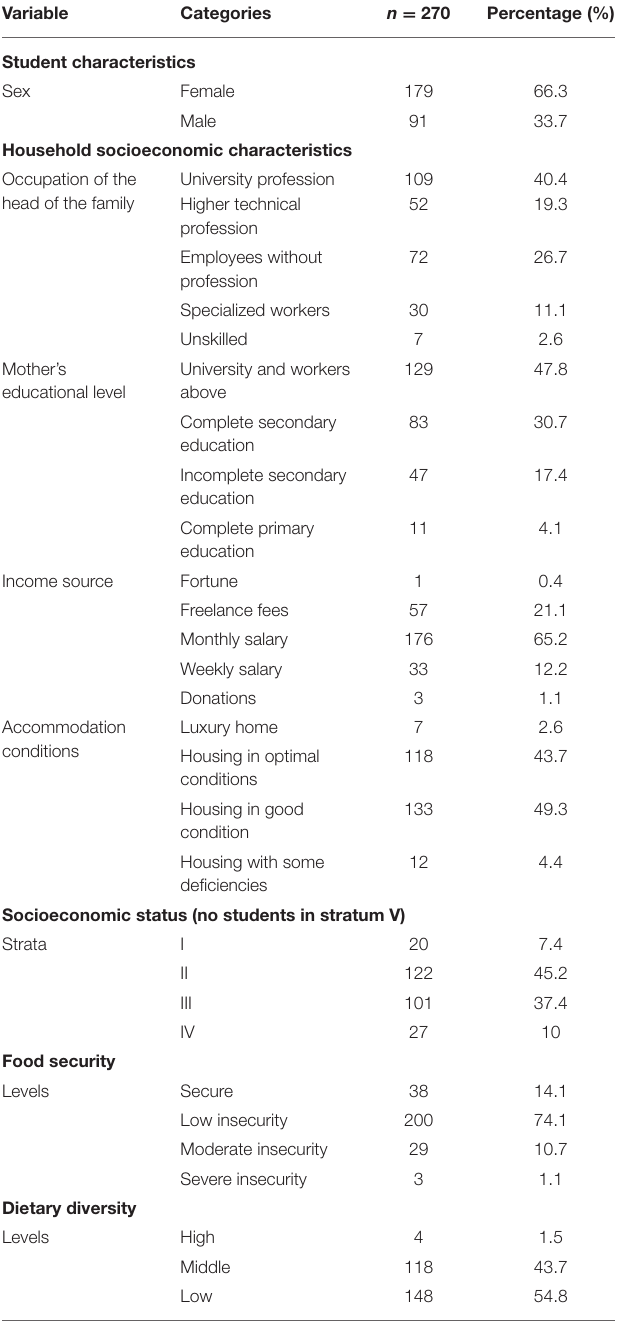
TABLE 1 | Socioeconomic characteristics of students’ households in Caracas,